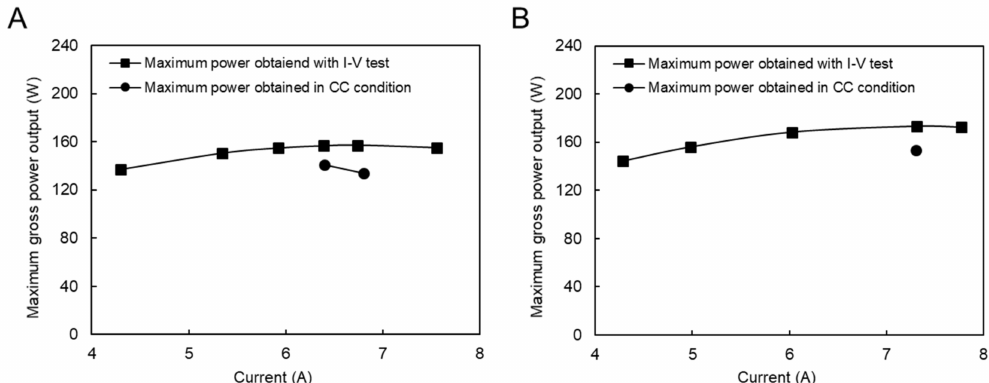
Figure 6. Constant current and I–V measurement with the natural RO brine and RW feed solution, ( A ) RO brine/RW; 26/20 (L/min), ( B ) RO brine/RW; 31/22